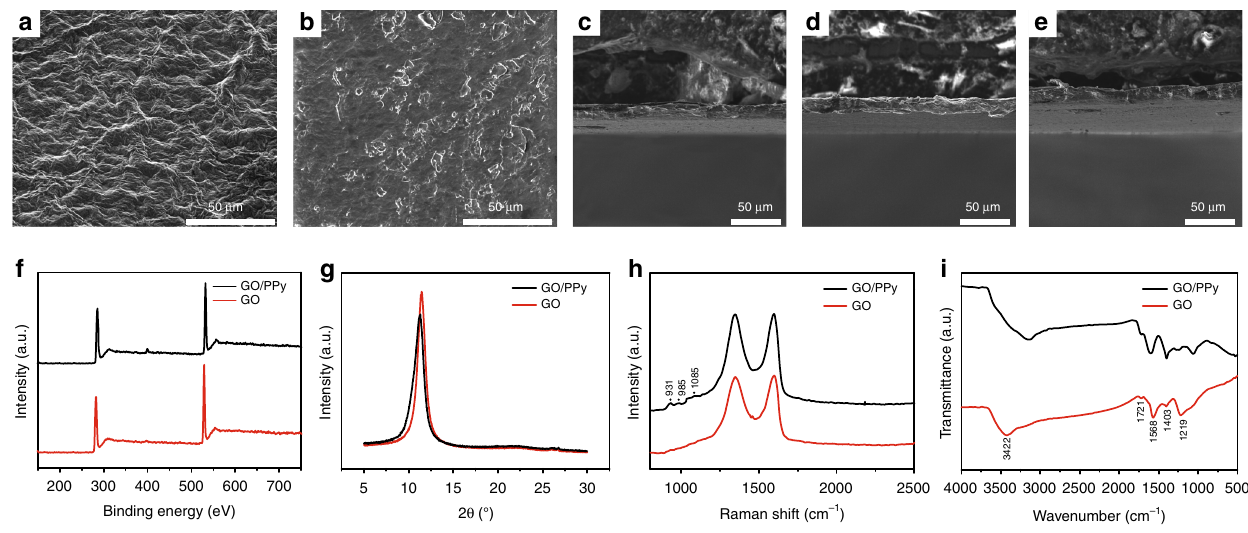
Fig. 2 Structural characterization of GO/PPy actuator. SEM image of a the GO fi lm side and b the PPy side; cross-sectional SEM image of GO/PPy actuators fabricated on the basis of GO fi lms with different thicknesses of c 12.8 μ m, d 25.2 μ m and e 37.1 μ m; f XPS spectra of GO and GO/PPy; g XRD pattern of GO and GO/PPy; h Raman spectra of GO and GO/PPy; i FT-IR spectra of pure GO and